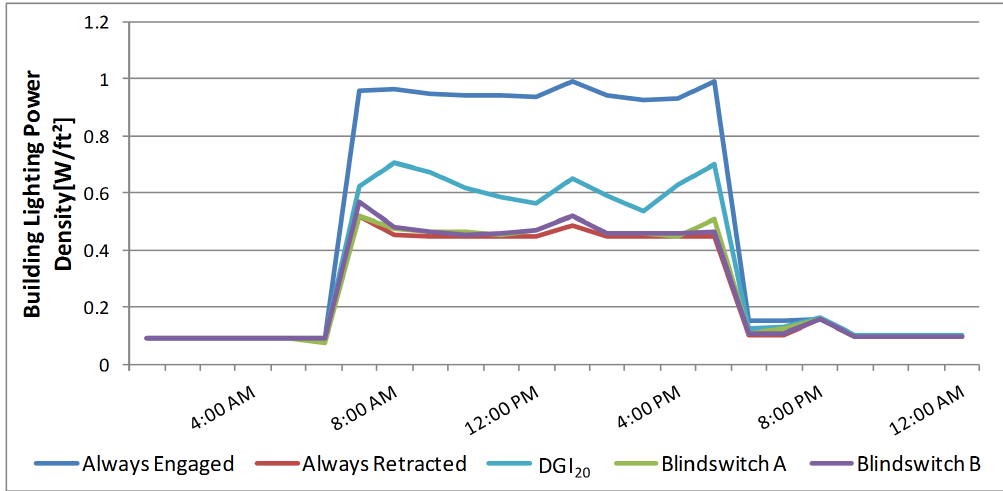
Figure 20. Fractional hourly electric light output comparison on 25